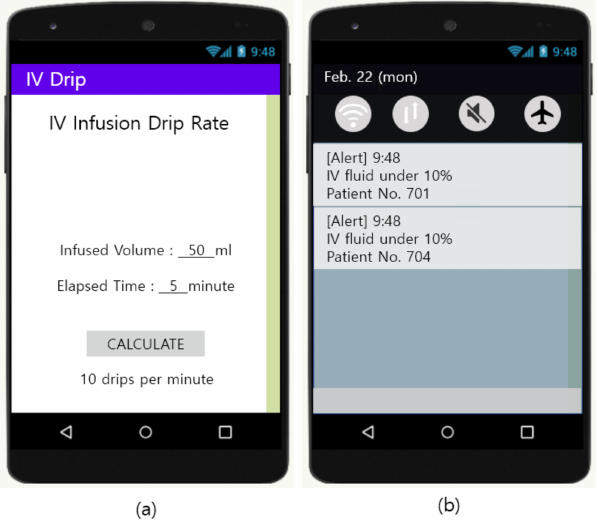
Figure 7. Captured image of the application on a mobile device. ( a ) Communication between the nursing station and microcontroller, and ( b ) image of a notification sent to a mobile